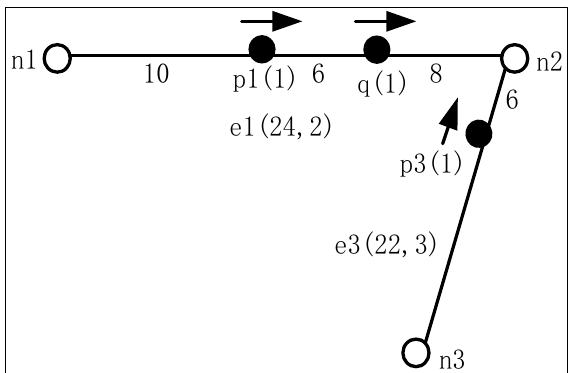
Figure 2. The local road network information.